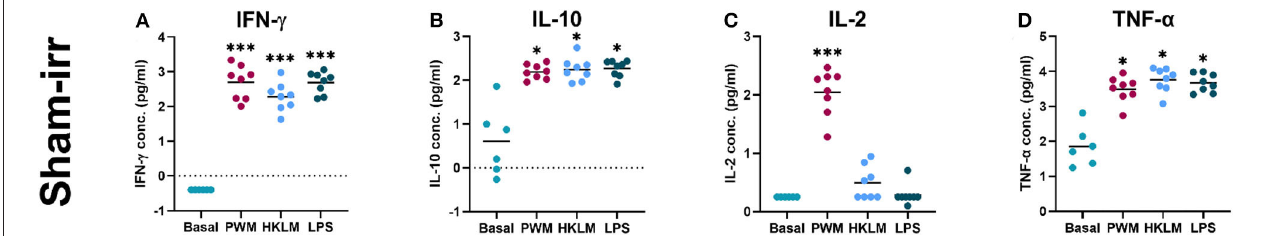
FIGURE 2 | Cytokine release assay validation—recall antigen and mitogen stimulation of whole blood samples. The graphs display the increase in log 10 -transformed, cytokine titres between the unstimulated (Basal) and the recall antigen- or mitogen-stimulated (PWM, HKLM, or LPS) samples. The dots represent the measurements of the individual participants and the horizontal lines denote means. The asterisks indicate various levels of significant difference (*** P < 0.001 and * P < 0.05). (A) All three stimuli significantly increased IFN- γ secretion. (B) All three stimuli result in a significant increase of IL-10 secretion compared to the basal level. (C) Only PWM